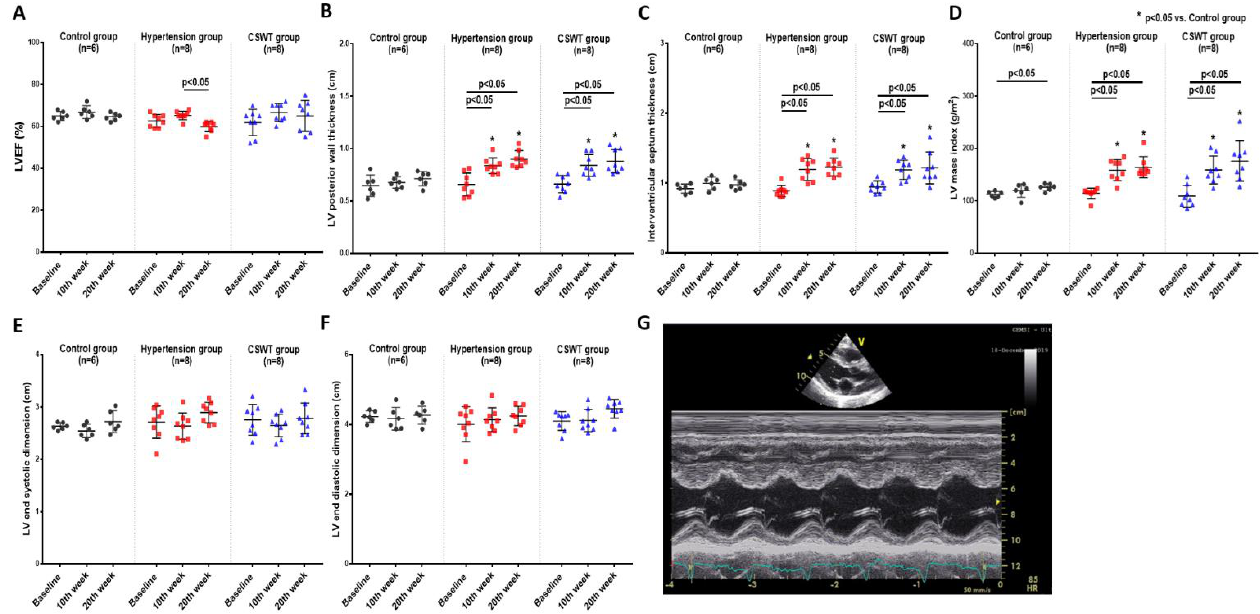
Figure 3. Echocardiographic data. Echocardiographic parameters at baseline, 10th week and 20th week follow − up in control, hypertension and CSWT groups. ( A ). No significant difference of LVEF (left ventricular ejection fraction) was observed in control and CSWT groups throughout the whole experiment. At the 20th week, LVEF decreased in hypertension group compared with that at the 10th week. ( B , C ). After induction of hypertension, LV (left ventricle) posterior wall thickness and interventricular septum thickness increased significantly in hypertension and CSWT groups at the 10th week and 20th week compared with those at baseline and in the control group. ( D ). LV mass index increased significantly in hypertension and CSWT groups compared with that of control group at the 10th week and 20th week. ( E , F ). No significant difference of LV end systolic dimension and LV end diastolic dimension were observed among the three groups throughout the whole experiment. ( G ). Representative echocardiographic M − mode tracing. Two − way repeated ANOVA with Tukey’s test was used, * p < 0.05 versus control group.